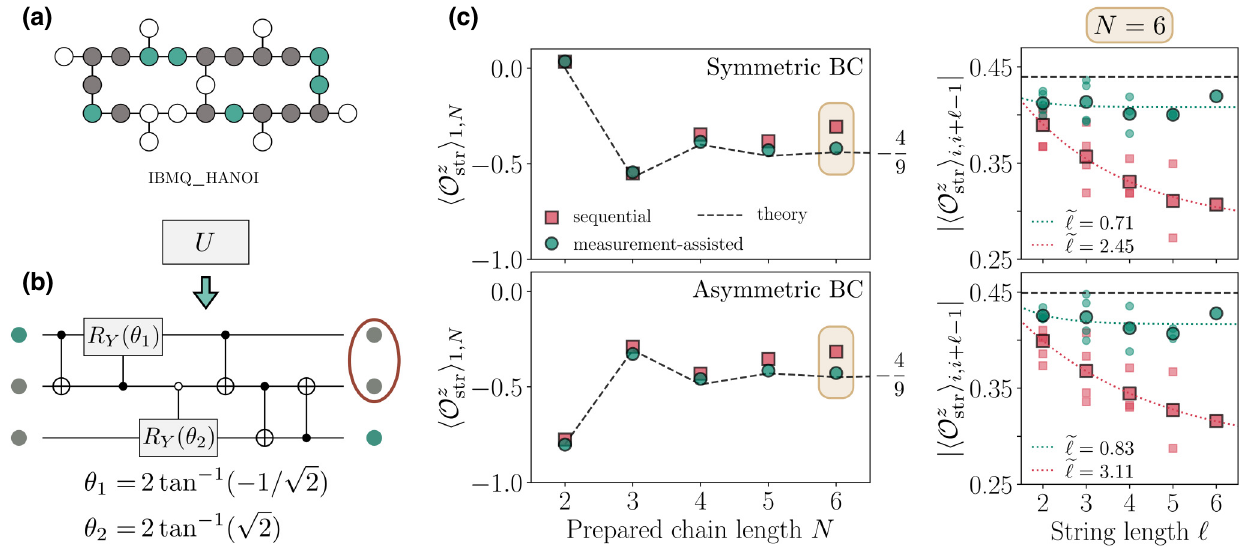
FIG. 6. Preparation of the AKLT state and measurement of the string order on IBM_HANOI . For all presented data, sampling uncer- tainties (estimated by bootstrapping measurement results acquired across 10 5 shots per circuit) are found to lie within the displayed markers and are therefore not shown. (a) The qubit connectivity on IBM_HANOI . The qubit colors indicate final qubit locations after measurement-assisted preparation of a N = 6 site AKLT state, the gray, green, and white circles corresponding to site, memory, and unused qubits, respectively. (b) The implementation of U , adapted to permute the memory qubit to the far edge, enabling both (cid:3) measurement-assisted and sequential preparation schemes with only linear connectivity. (c) The measured string order (cid:4) O z str i , i + (cid:5) − 1 after sequential (red) and measurement-assisted (green) preparation, compared to the theoretical expectation (dashed black line). The left-hand panels display the string order measured from edge to edge ( i = 1, (cid:5) = N ) for a length N chain, with the top and bottom distinguishing between postselection upon measurement of symmetric ( | L (cid:3) = | R (cid:3) ) and asymmetric ( | L (cid:3) = X | R (cid:3) ) boundary conditions. (cid:3) | for N = 6 and varying string lengths (cid:5) . The small transparent markers The right-hand panels show measured values of | (cid:4) O z str i , i + (cid:5) − 1 represent individual measurements for varying i , while the large bold markers indicate their average value for each (cid:5) and the dashed (cid:9) (cid:5) + (cid:9) (cid:5) lines correspond to their best fit to an exponential curve Ae − (cid:5)/ are shown in the legend, B to guide the eye. The best-fit values for with coefficients A and B reported in the Supplemental Material